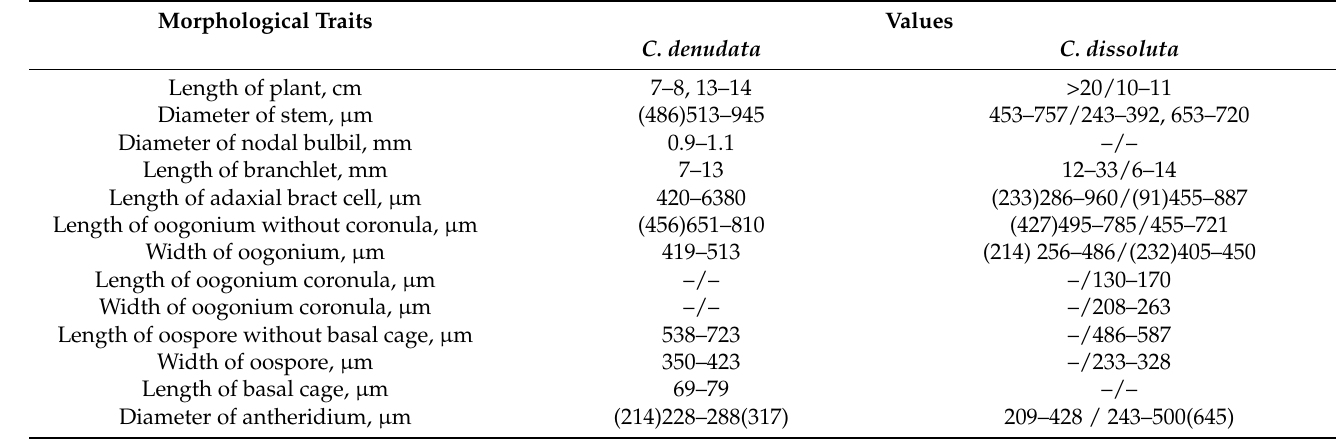
Table 1. Morphometry of the studied specimens of Chara denudata and C. dissoluta . All measurements were taken in a dry state from the pressed specimens of C. denudata (isolectotypes) and from the pressed (lectotype)/living plants of C. dissoluta